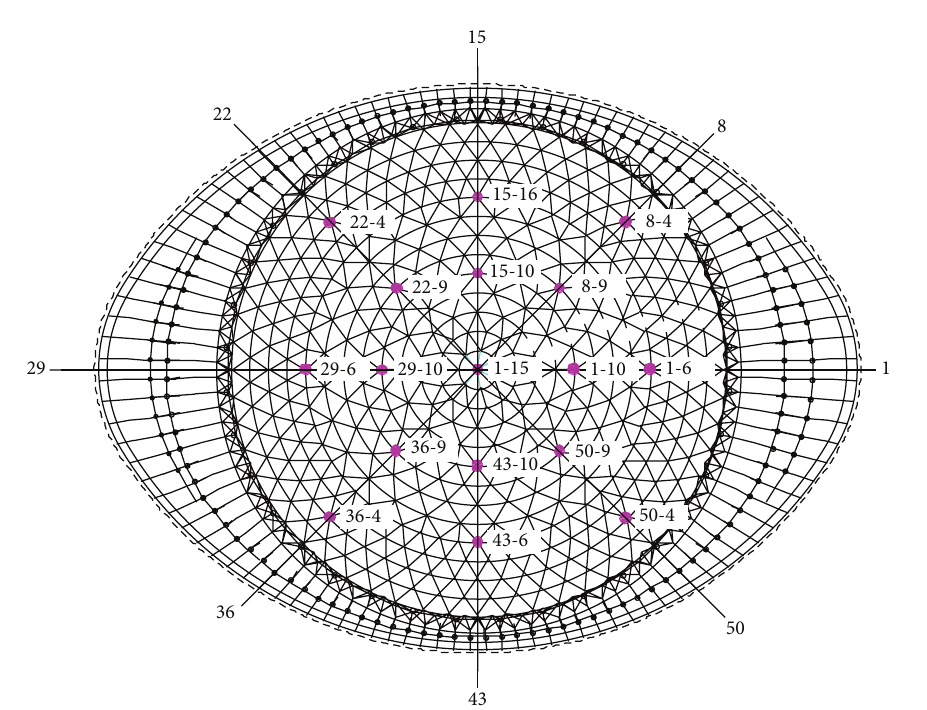
Figure 8: Axial force of members on the upper dome.